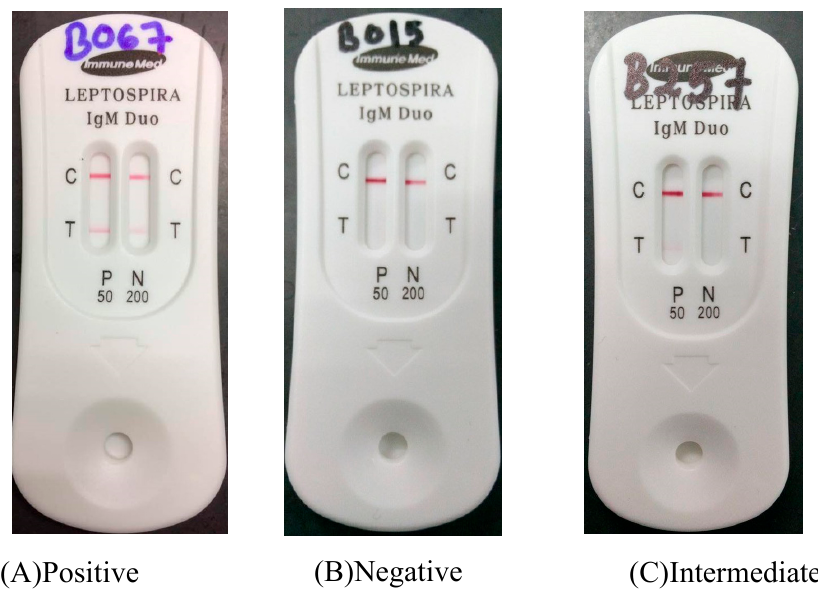
Figure 1. Example of the results for Leptospira IgM Duo Rapid test.